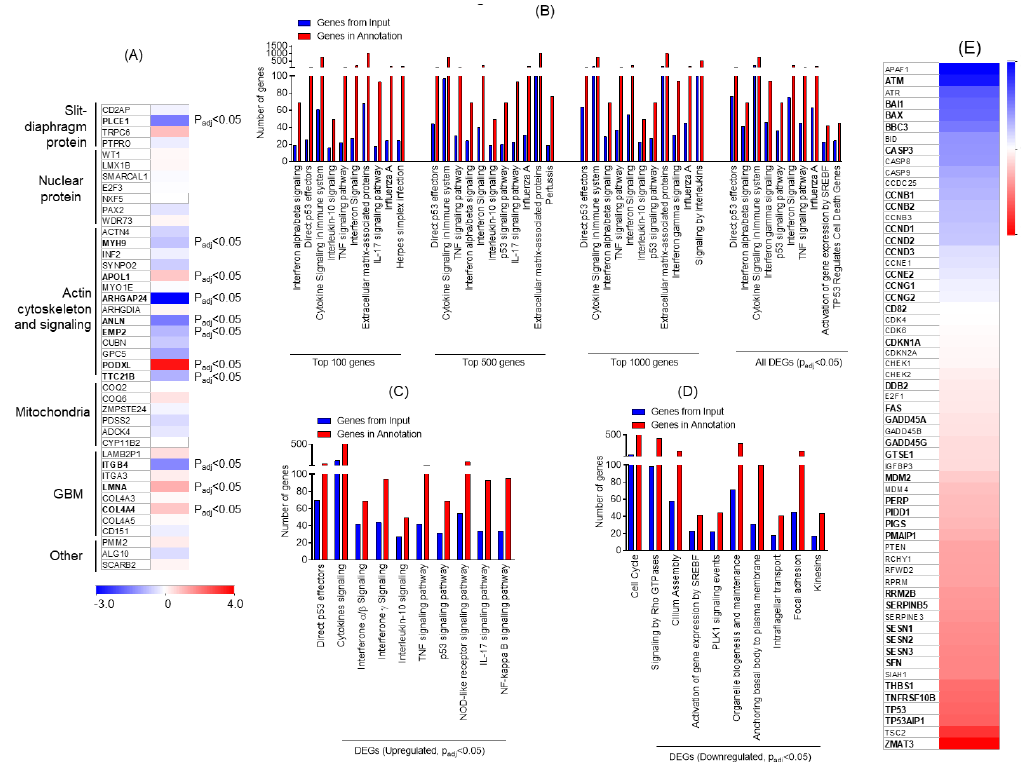
Figure 2. ( A ) Heat map for genes that are known to associate with nephrotic syndrome and were significantly altered upon ADR injury in podocytes, plotted from the RNA-seq data. Letters in bold denote statistical significance (Padj ≤ 0.05). ( B ) Gene Ontology (GO) analysis for the enrichment